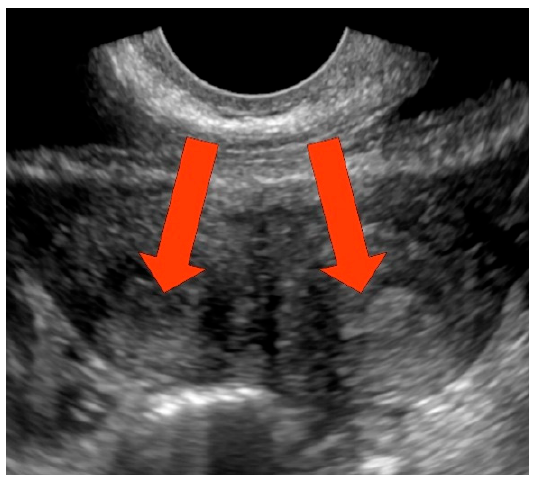
Figure 1. Sonogram of a 13-year-old patient imaging two uterine bodies with endometrium. There was no blood in the uterus.